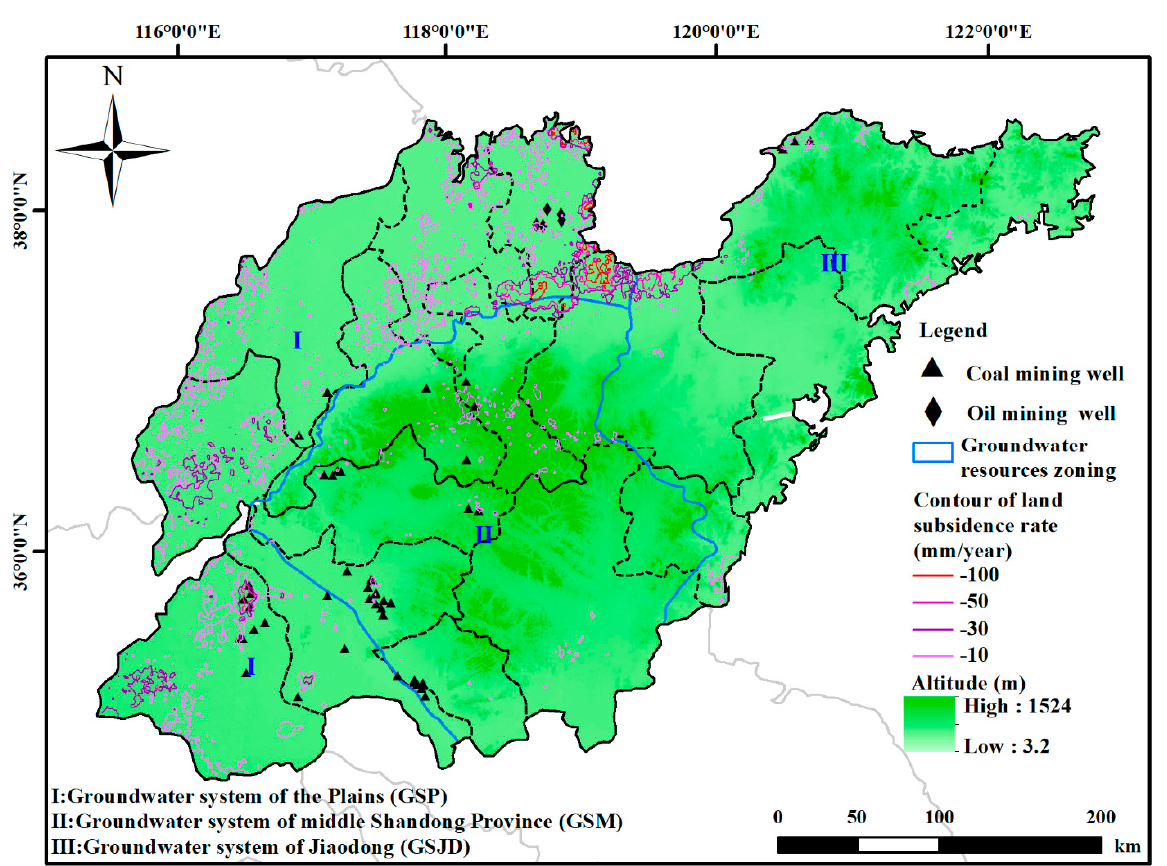
Figure 11. Relationship between land subsidence and underground mining of mineral resources.